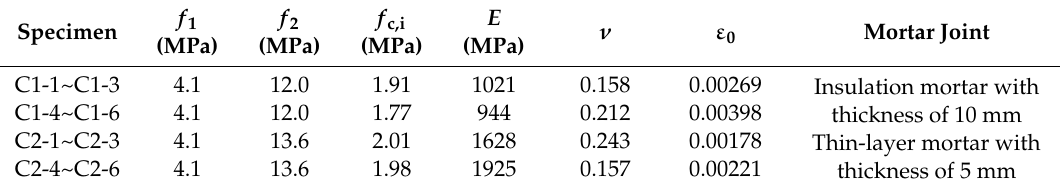
Table 4. Test results of compressive strength of AAC self-insulation